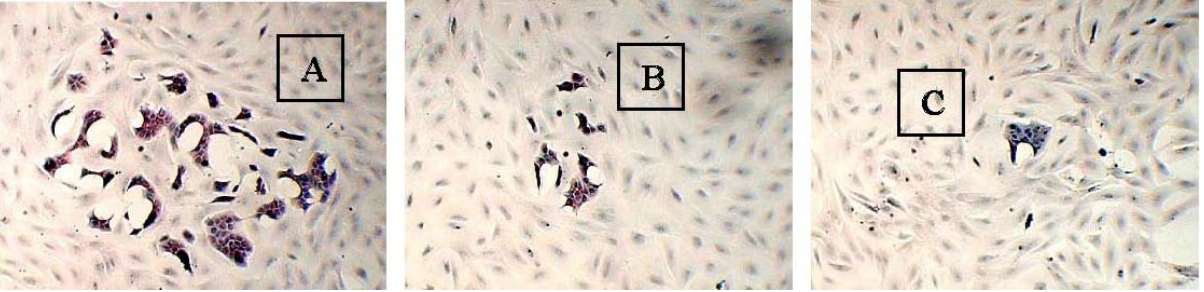
Figure 5. The BT-474 colonies on the feeder layer of MCF-10A cells preincubated with pioglitazone and/or serum-rich growth media. ( A ) Large BT-474 colonies in this study were denoted as a cell population of about 1–2 mm diameter on the preincubated MCF-10A feeder layer; ( B ) moderate BT-474 colonies were defined as a cell population of about 0.5 mm diameter on the preincubated MCF-10A feeder layer; and ( C ) small BT-474 colonies were defined as a cell population of less than 0.2 mm diameter on the preincubated MCF-10A feeder layer. The pictures were taken with 40× magnification, where 0.01 mm was equal to 10